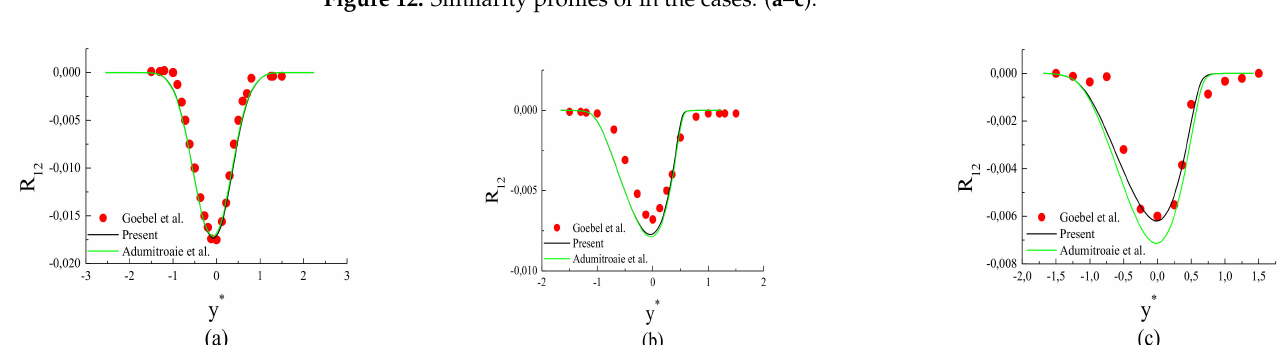
Figure 12. Similarity profiles of in the cases: ( a – c ).